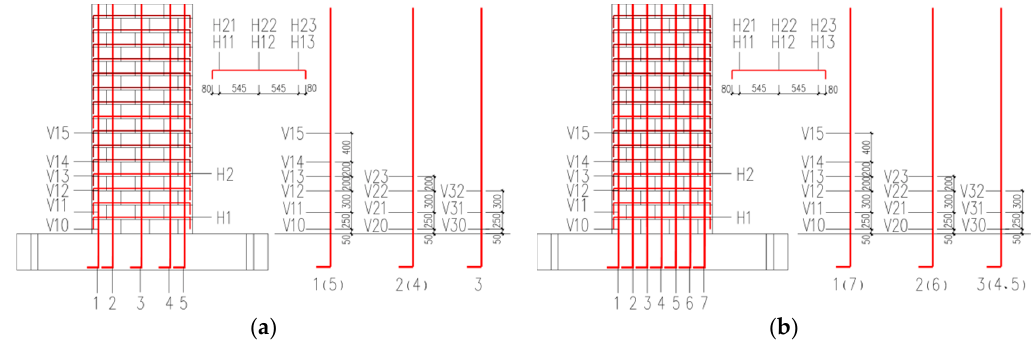
Figure 5. The internal instrumentation for cyclic test: ( a ) Strain gauges of PMW-1 and PMW-2; ( b ) strain gauges of PMW-3A/B and PMW-4.